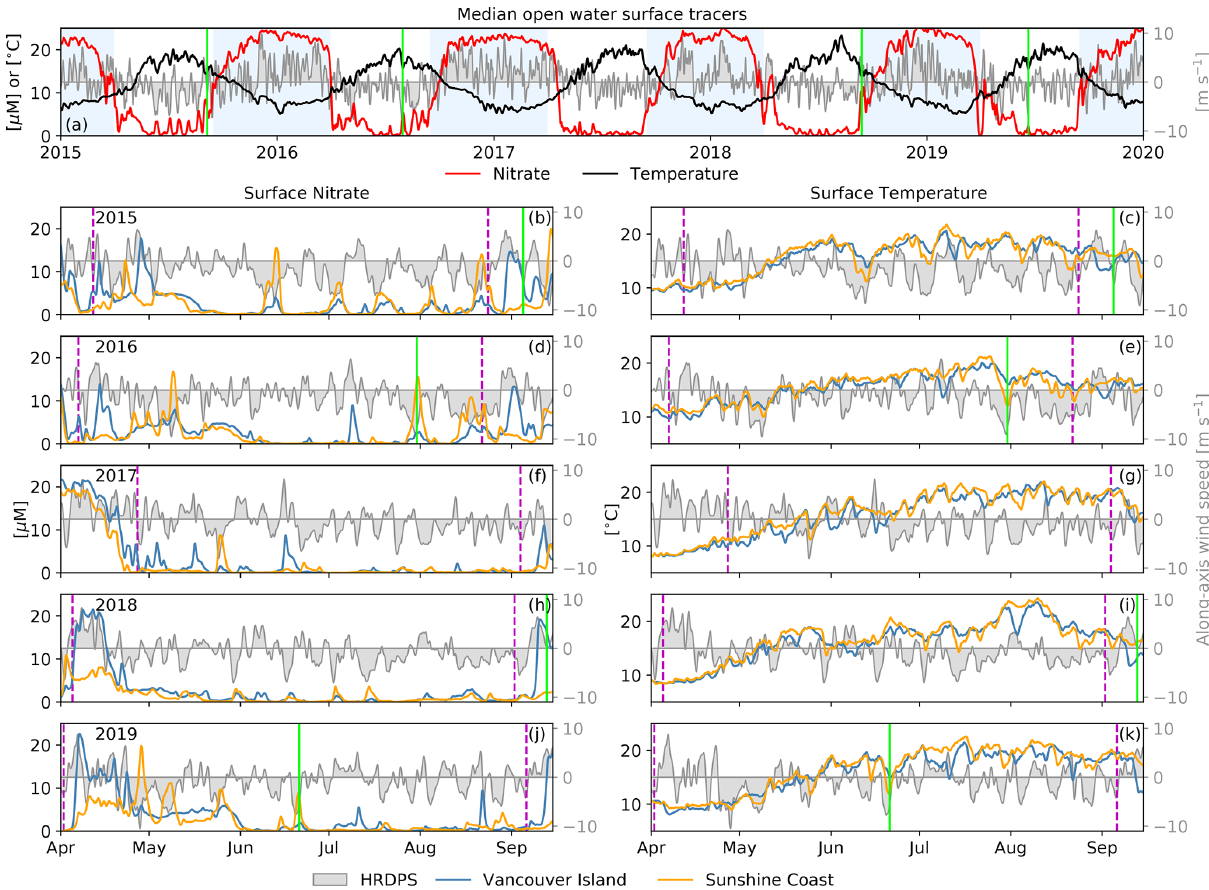
Figure 5. Time series of SalishSeaCast hourly surface nitrate and temperature during 2015–2019 as (a) spatial medians over the open-water region and (b–k) spatial medians over the coastal grid points shown in Fig. 4. The open-water spatial median of HRDPS hourly along- axis surface wind speed is also shown (gray patch). Interquartile ranges for temperature and nitrate are included in a companion figure in the Supplement (Fig. S1). The nitrate, temperature and wind speed records have been low-pass filtered using a 3d Blackman window to emphasize the subtidal variability. The 1 April to 15 September extent of the lower panels is indicated by the white regions in (a) . The seasonal cutoffs bounding the productive season for each year (magenta dashed lines) and the dates of the four MODIS images shown in Fig. 2 (solid green lines) are also shown. Nitrate and temperature follow clear seasonal cycles, with higher frequency variability during the summer that visibly overlaps with wind